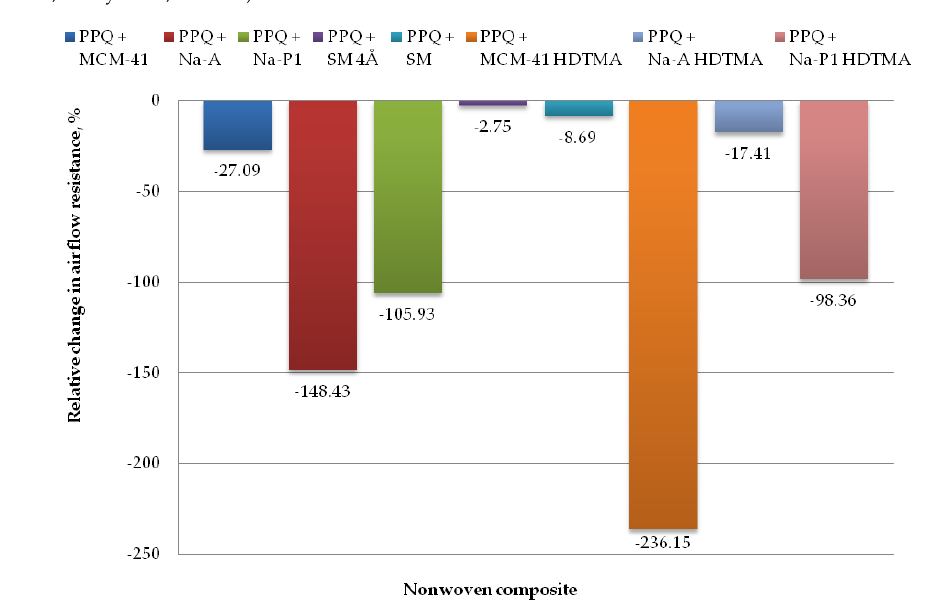
Figure 12. Relative change in airflow resistance for nonwoven zeolite and silica composite.